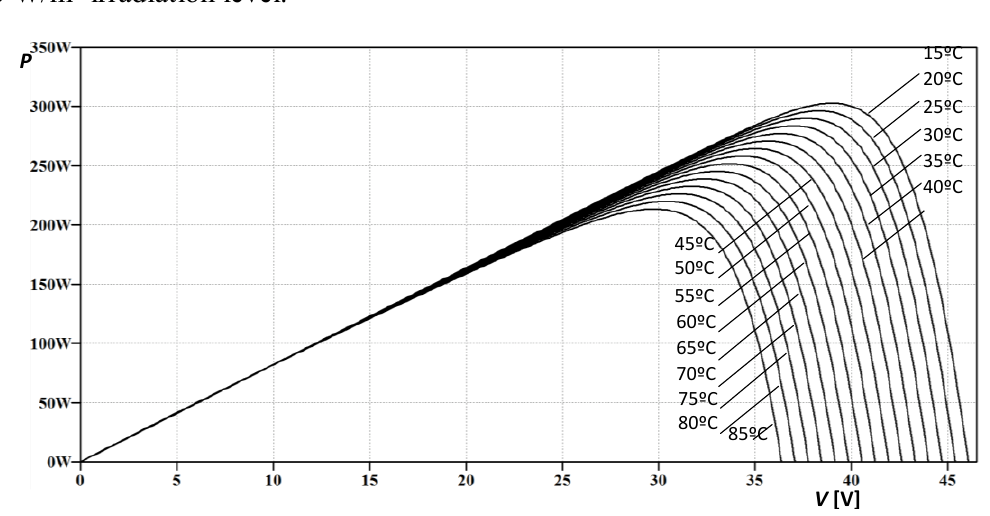
Figure 9. Power curves of panel MSMD290AS-36.EU simulated with LTSpice calculation of the equivalent circuits for different temperature levels, from 15 °C to 85 °C, with 1000 W/m 2 irradiation level.